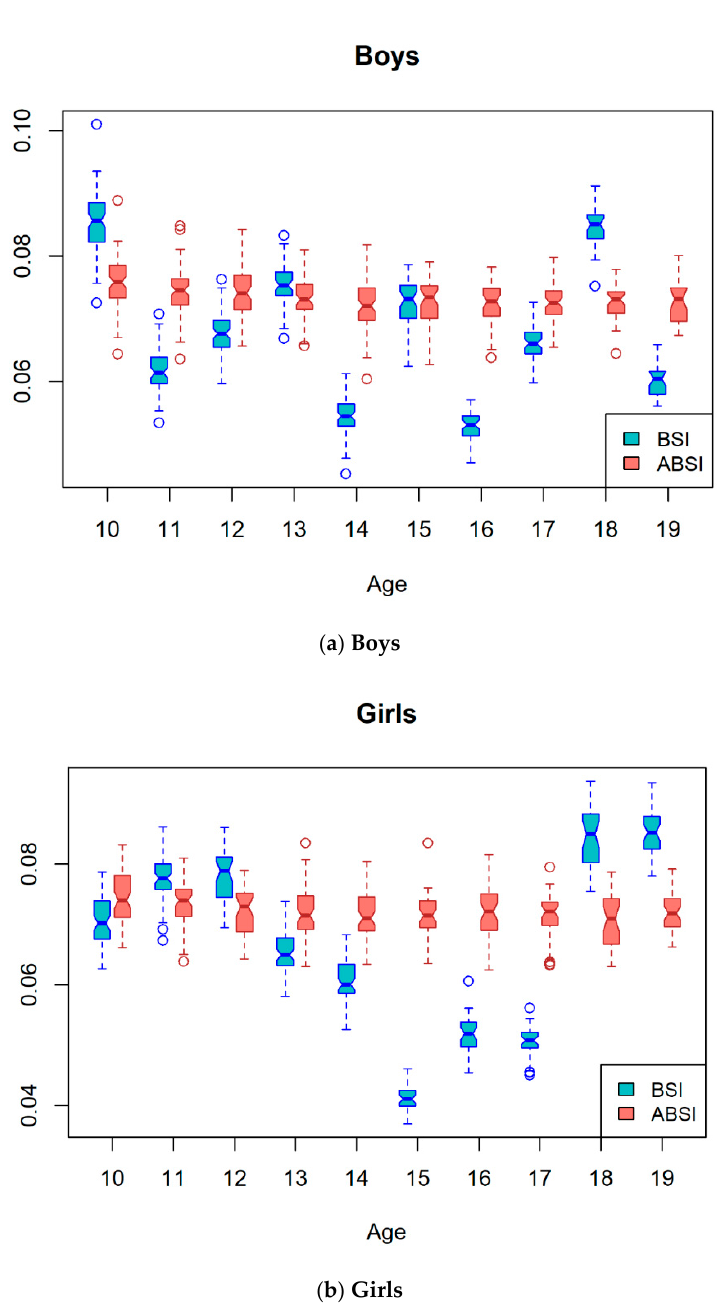
Figure 2. Comparison between mean BSI and ABSI among boys and girls according to age. BSI body shape index, ABSI a body shape index.